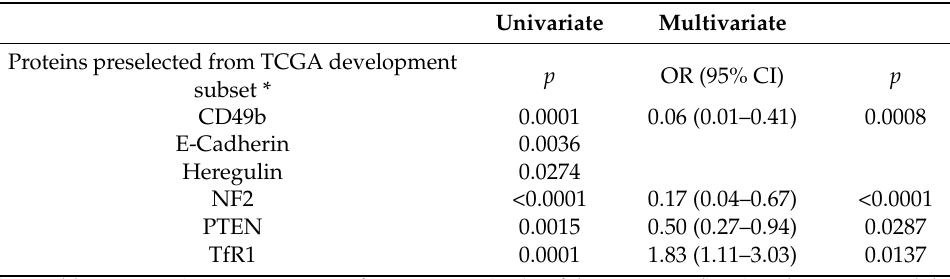
Table 1. Univariate and multivariate analysis of RPPA outcomes for prediction of nodal involvement— TCGA validation subset ( n = 299) *.